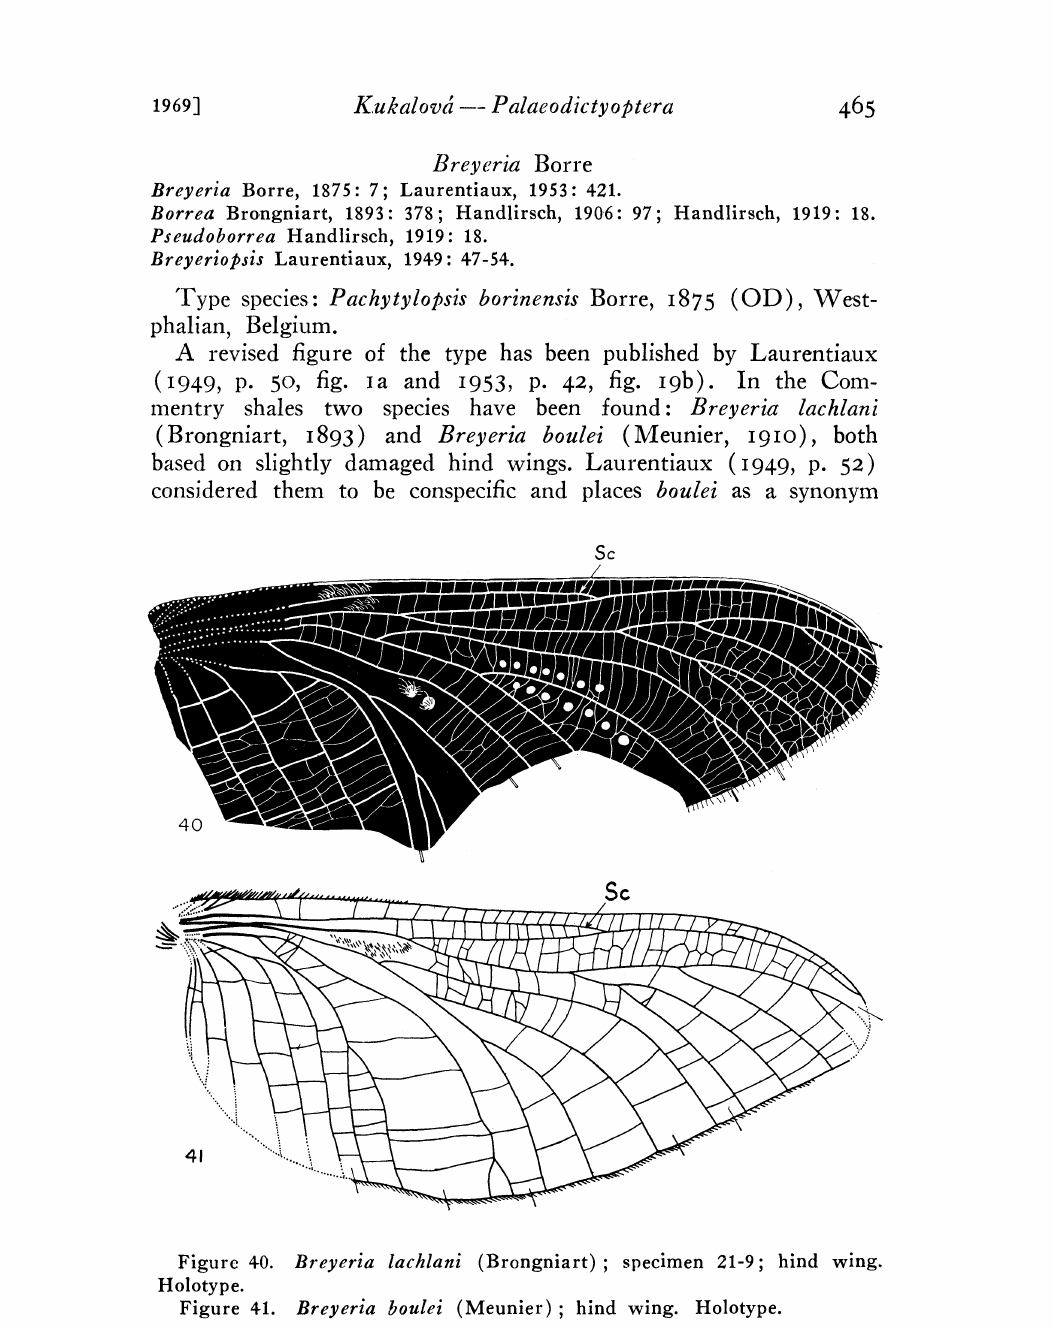
Figure 40. Breyeria lachlani (Brongniart); specimen 21-9; hind wing. Holotype. Figure 41. Breyeria boulei (Meunier); hind wing.